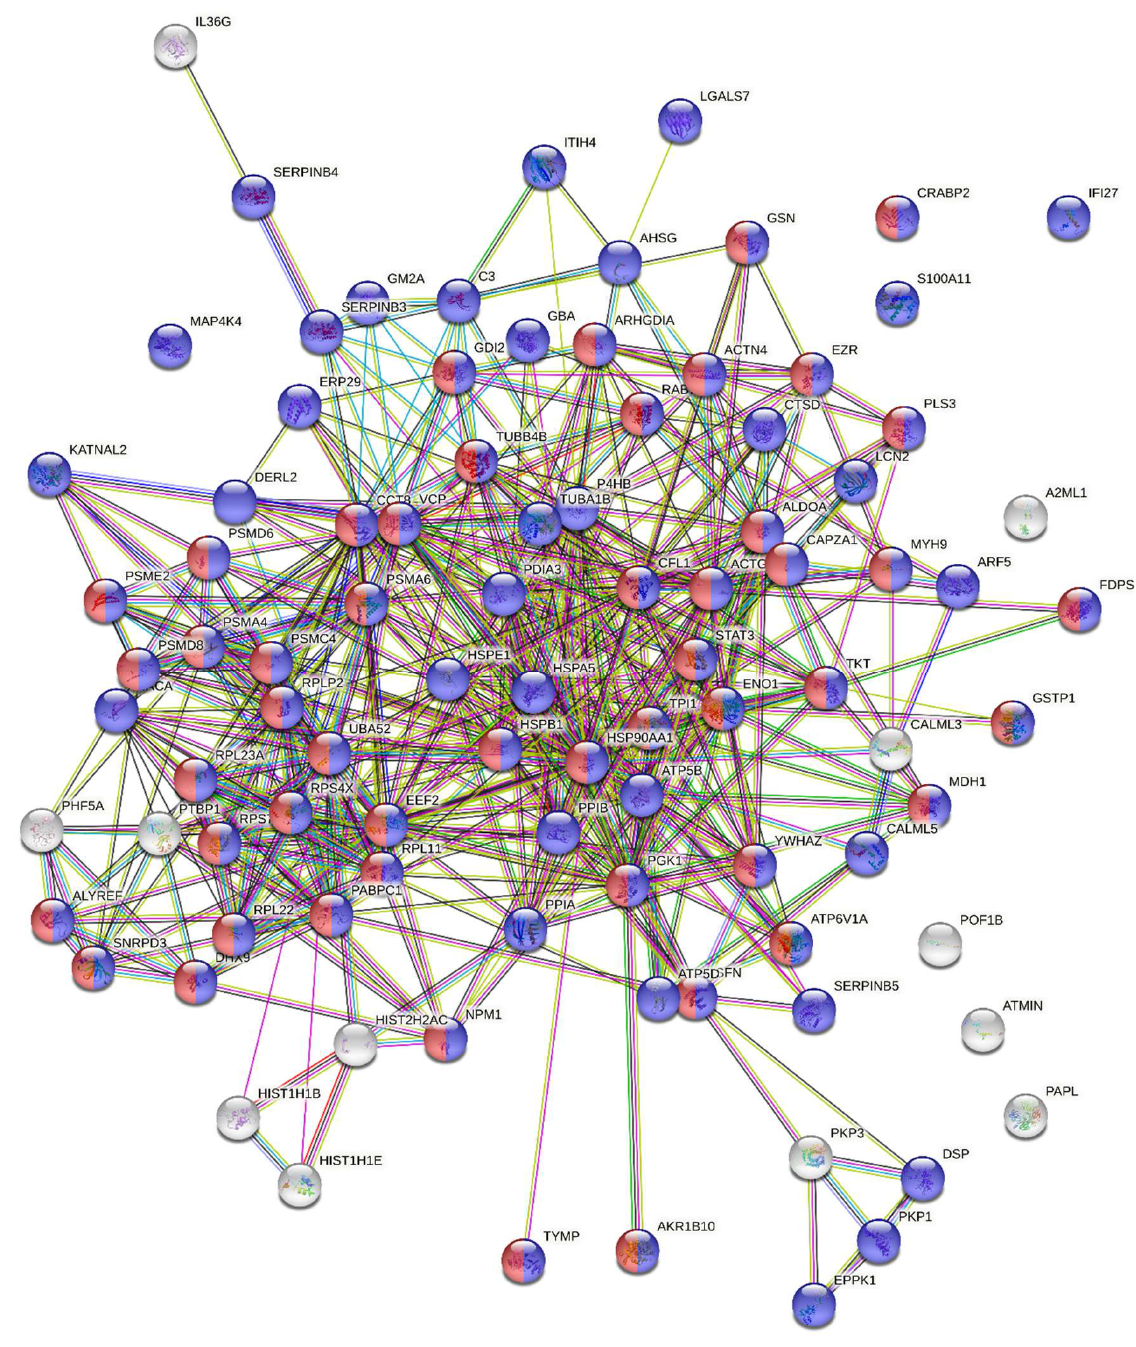
Figure 5. Bioinformatic analysis of proteins present in the EBC at lower amounts in PE ( n = 90). The number of edges is 500. For a random set of 90 proteins, 195 edges would be expected. The number of interactions is significantly higher than expected ( p < 1 × 10 − 16 ). Blue nodes: cytoplasm proteins (82). Red nodes: cytosol proteins (50). The protein–protein interaction enrichment p -value was estimated based on a Random Graph with Given Degree Sequence (RGGDS), as described in